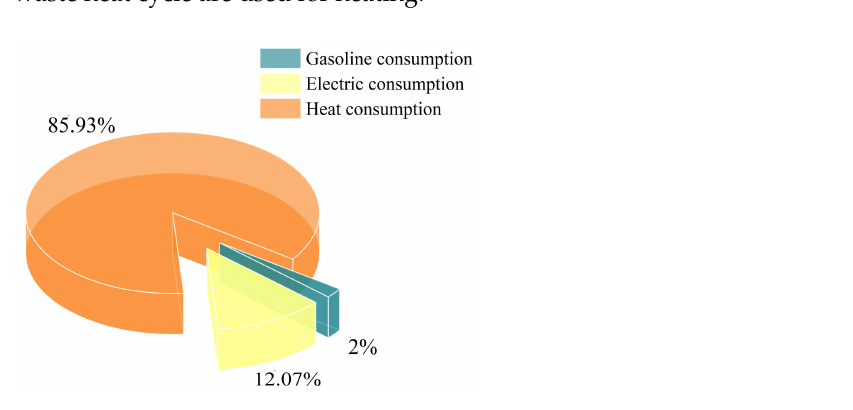
Figure 4. Distribution of consumption of three kinds of energy for the non-phase-transition drying pyrolysis and mass conversion technology.